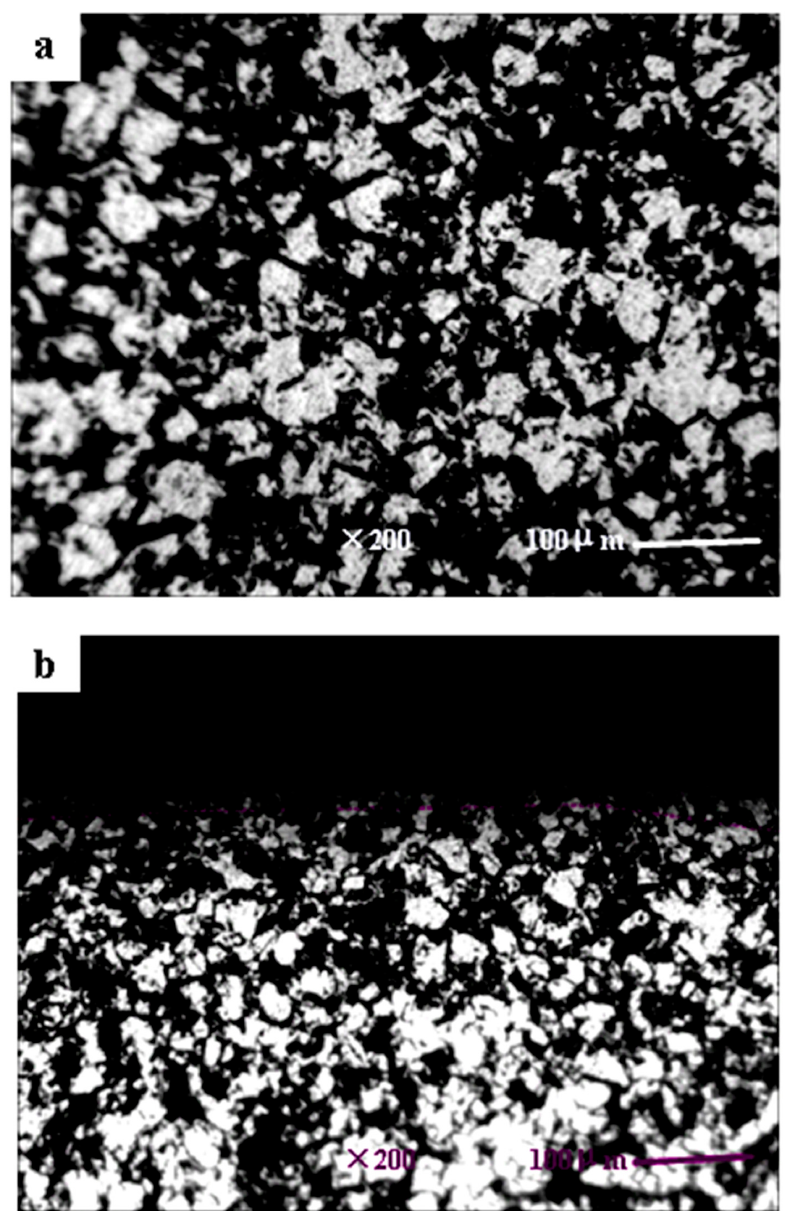
Figure 3. Optical micrograph of TLM titanium alloy: ( a ) Base material; ( b ) UI-48000.